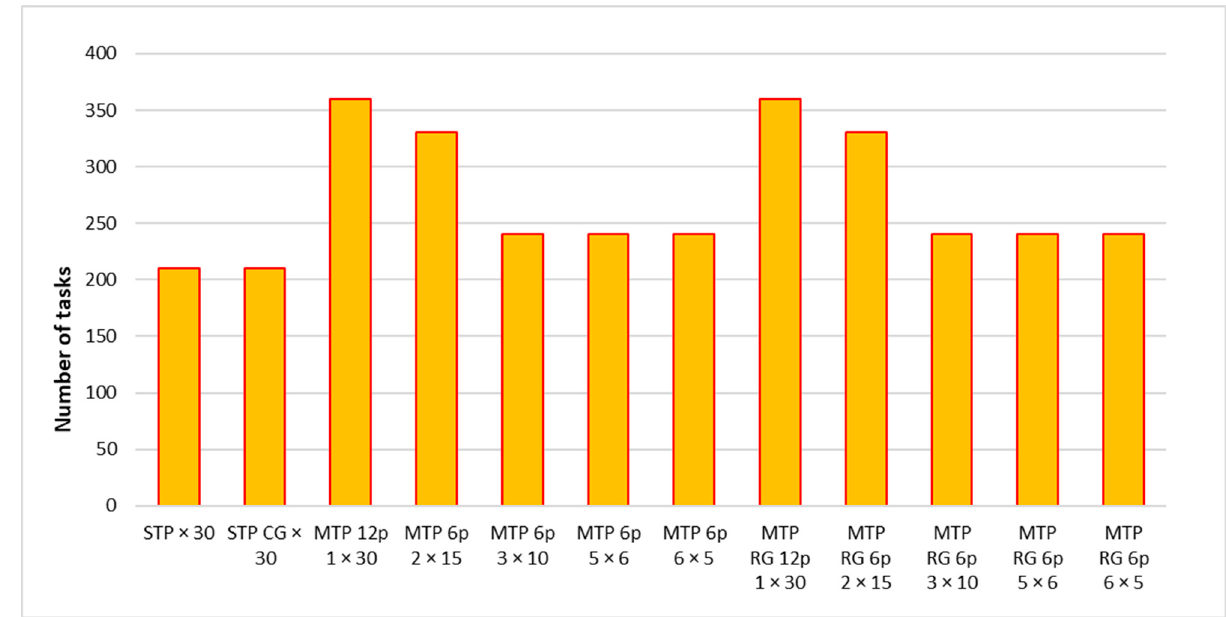
Table 4. Results obtained for different systems with the same productivity: SP = 150.